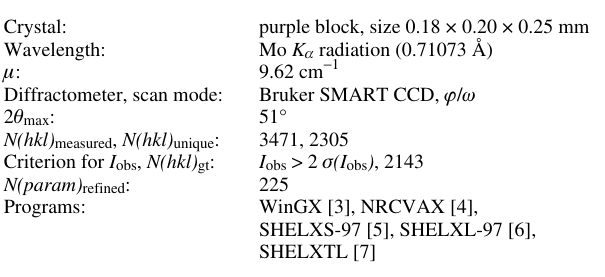
Table 1. Data collection and handling.